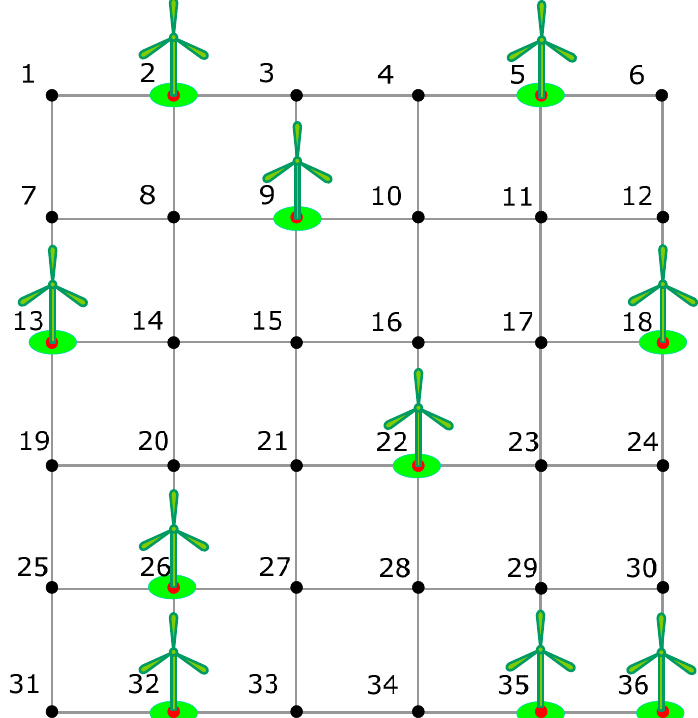
Figure 2. Optimal solution of the wind turbine placement problem without considering equality constraints.